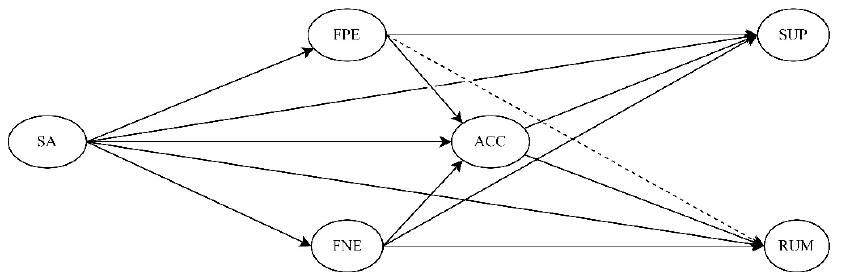
Figure 1. Conceptual model of fears of evaluation as mediators between social anxiety and emotion regulation. SA = social anxiety; FPE = fear of positive evaluation; FNE = fear of negative evaluation; SUP = suppression; ACC = acceptance; RUM = rumination. Control variables are not displayed for the sake of clarity. The dotted line represents the control path from FPE to RUM, assumed to be non- significant.